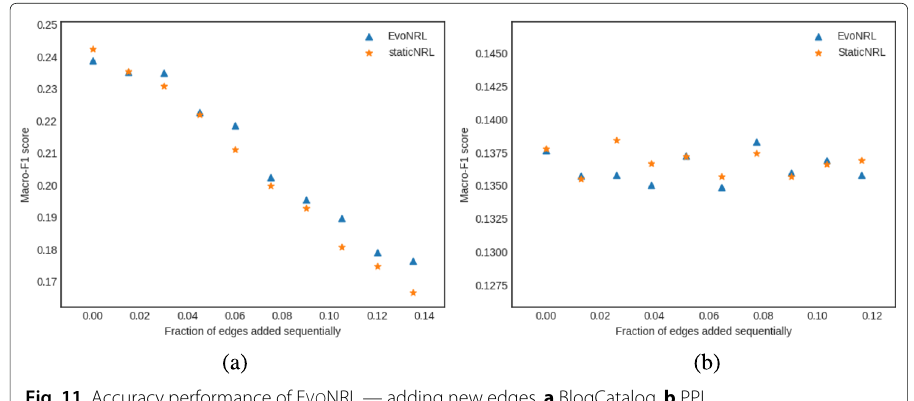
Fig. 11 Accuracy performance of E VO NRL — adding new edges. a BlogCatalog, b